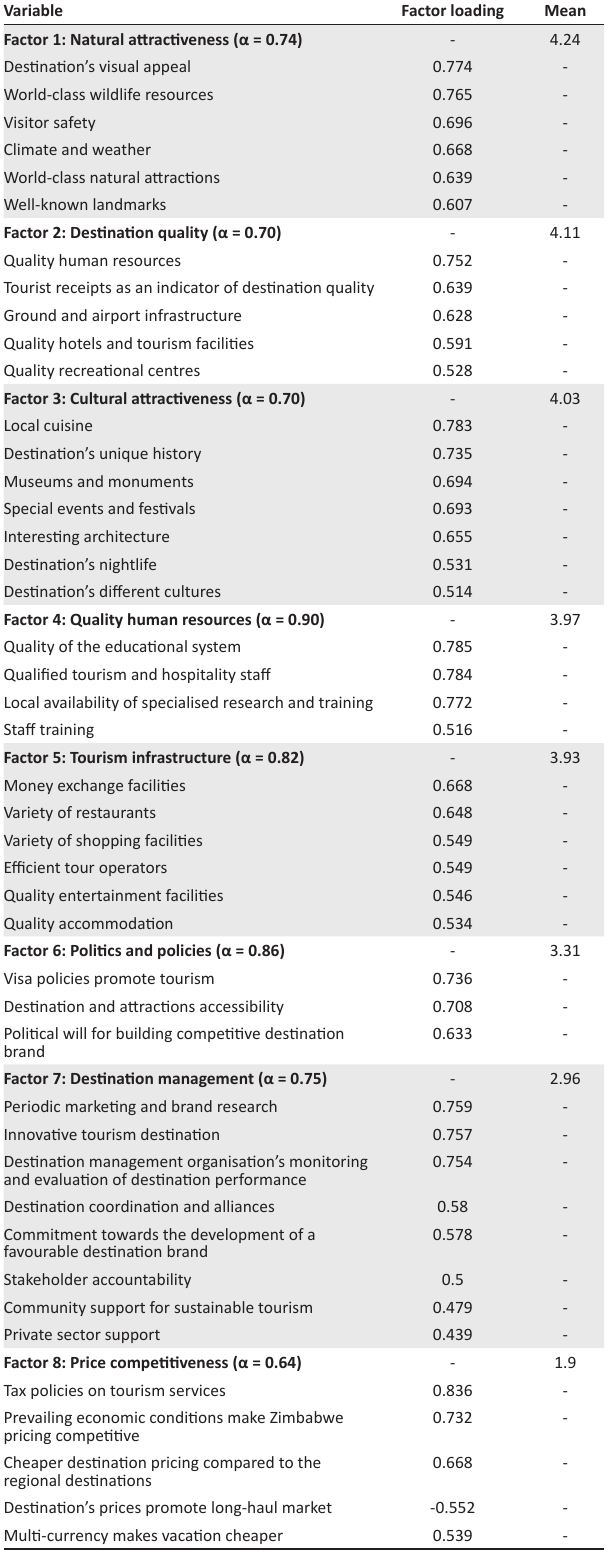
TABLE 2: Results of exploratory factor